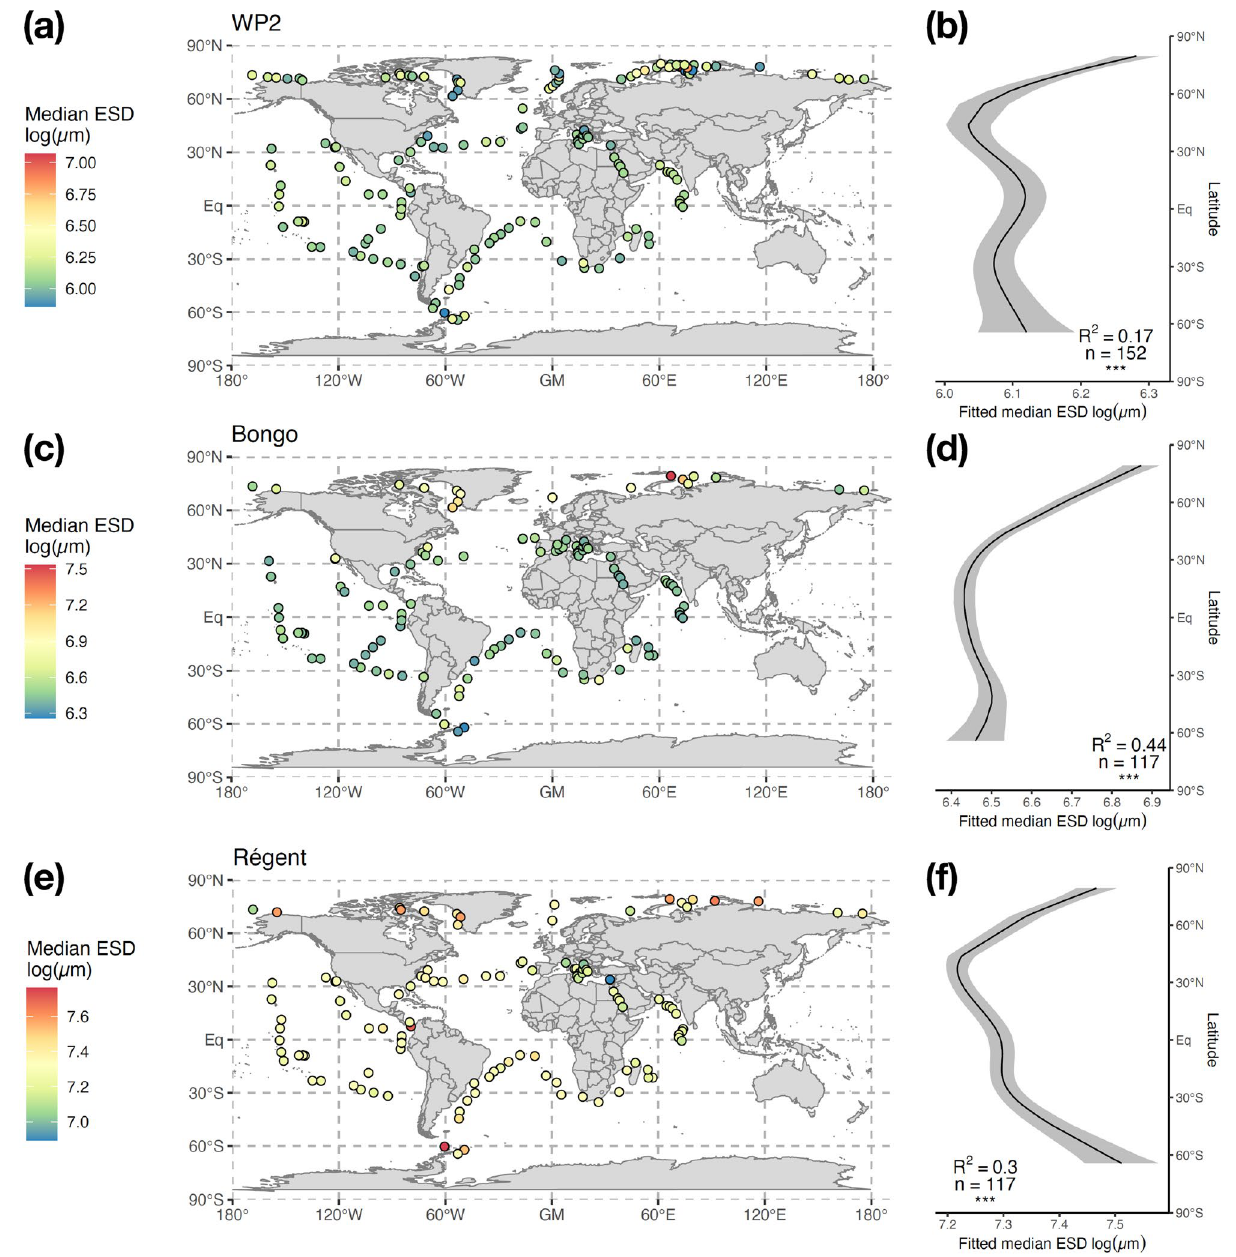
Figure 3. Maps and latitudinal patterns of the logged median Equivalent Spherical Diameter (ESD, µm) observed for Copepoda based on ( a , b ) WP2 samples (200 µm mesh), ( c , d ) Bongo samples (300 µm mesh) and ( e , f ) Régent samples (680 µm mesh). The major and minor axes of the best fitting ellipses were measured for each organism to estimate their ESD. Community-level size structure was determined through the median value of the ESD distribution at individual-level. The solid curves in the right-hand side plots illustrate the prediction from the Generalized Additive Model (GAM) fitting median ESD as a function of latitude. The explanatory power of the GAM (adjusted R2), the number of samples used and the significance of the smooth term (p < 0.001 = ***, p < 0.01 = ***, p < 0.05 = *, p > 0.05 = ns) are reported on the plots. The grey ribbon illustrates the standard error of the prediction. Only the stations where ESD was measured for at least 20 individuals were